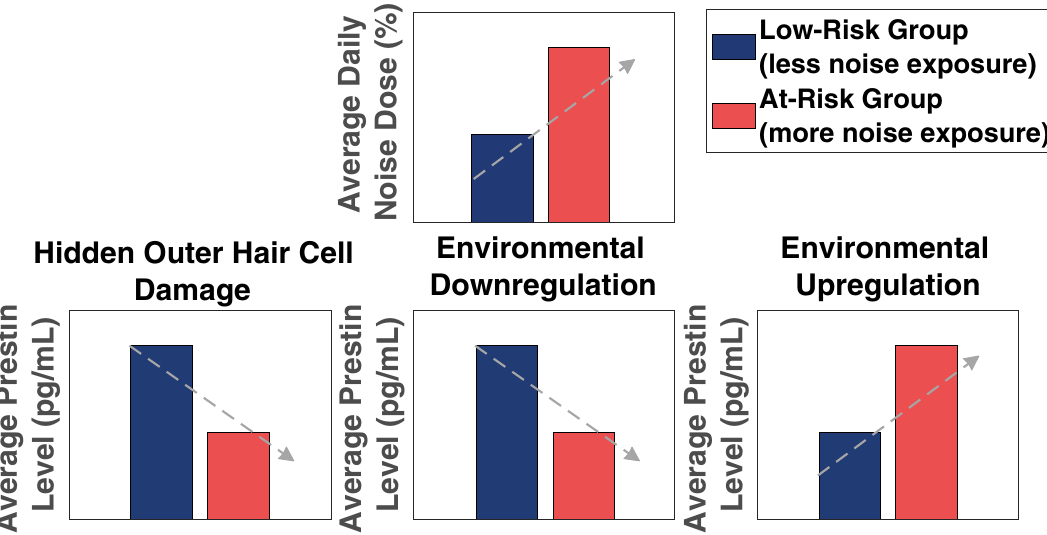
Figure 2. Three hypotheses for serum prestin and noise exposure. The predicted outcome of each hypothesis is illustrated by comparing groups with different levels of risk for noise-induced hearing loss, based on their average daily noise dose. In the current study, risk estimate was based on three weeks of objective environmental sound level measurements taken from body-worn noise dosimeters. We classified the young adults in our sample as at-risk if their daily noise doses exceeded 100% on average across the three weeks. Dose factors in both duration and intensity (in dBA) of exposure, with 100% dose defined as the upper limit of exposure that is considered safe from a regulatory standpoint. The gray arrows represent the direction of the predicted relationships between average daily noise dose and serum prestin levels, when noise exposure is treated as a continuous variable. The Hidden Outer Hair Cell Damage Hypothesis and Environmental Downregulation Hypothesis both predict a negative relation between serum prestin and noise levels, with individuals with higher noise doses having lower levels of serum prestin. However, the Hidden Outer Hair Cell Damage Hypothesis would also predict a negative relation between serum prestin and extended high frequency audiometry, while the Environmental Downregulation Hypothesis would not. Conversely, the Environmental Upregulation Hypothesis predicts a positive relation, with individuals with higher noise doses predicted to have higher serum prestin